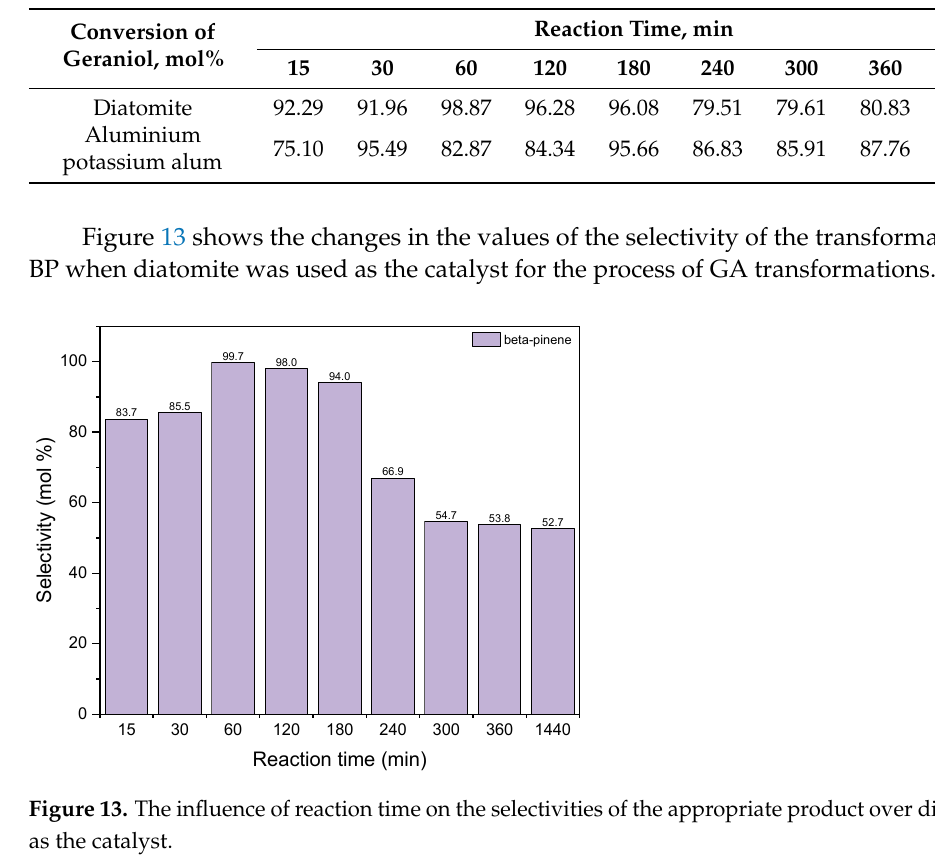
Table 6. The influence of the reaction time on the conversion of GA.